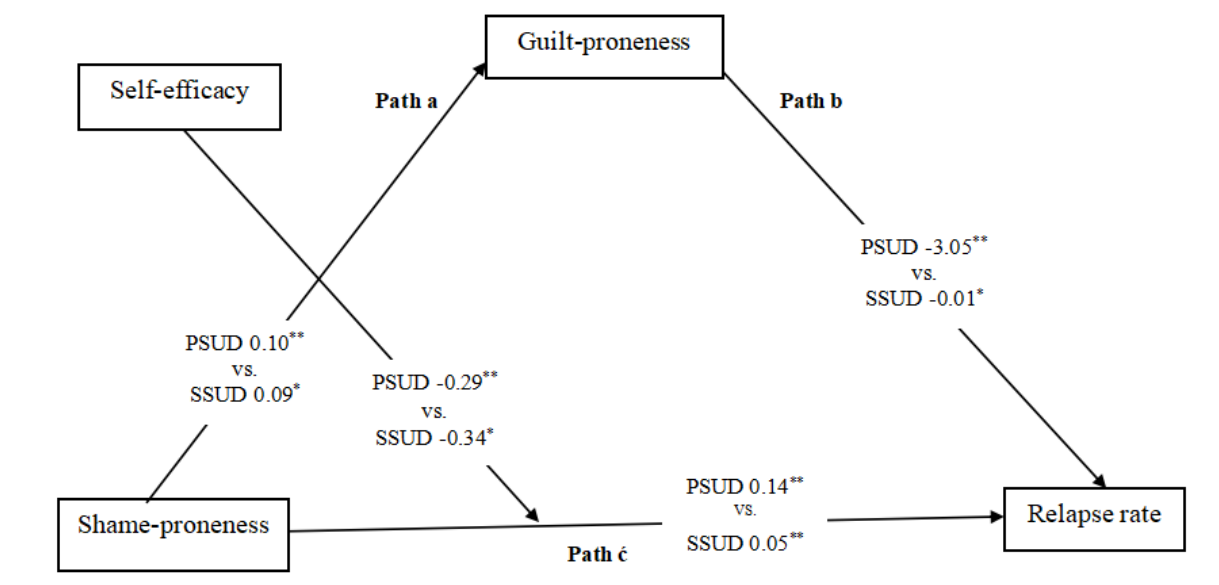
Figure 1. A conceptual framework and hypothesized model; * p < 0.05, ** p < 0.01